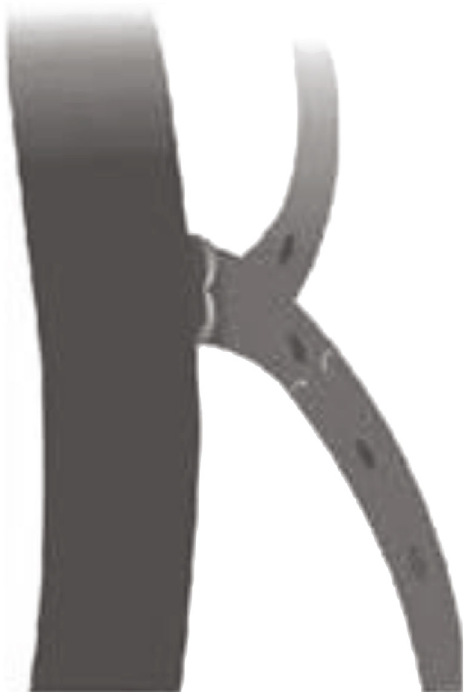
Figure 12: Incompetent GSV due to arch